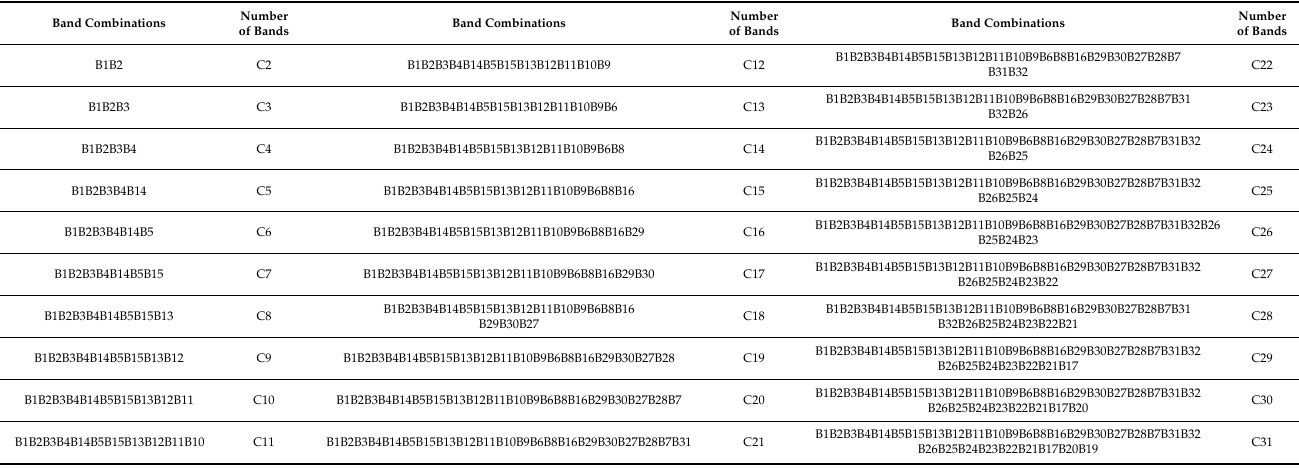
Table 3. Relationship between band combinations and number of